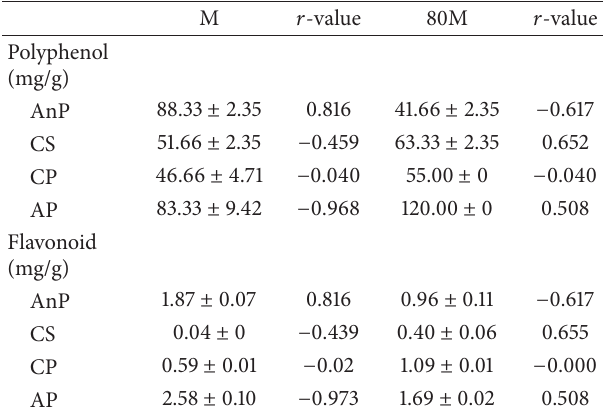
Table 3: Correlation between the antioxidant activity of plant extracts against lipid oxidation in brain homogenate and the content of polyphenol and flavonoid in the